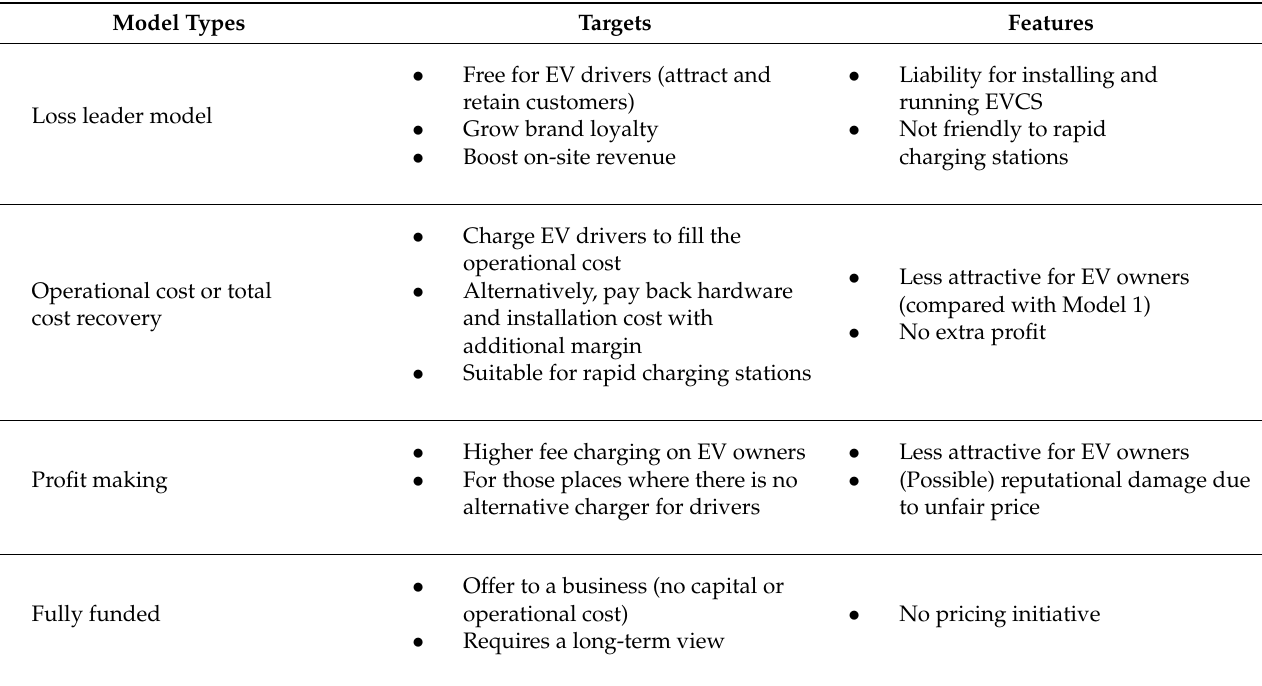
Table 5. Business models for commercial EV charging